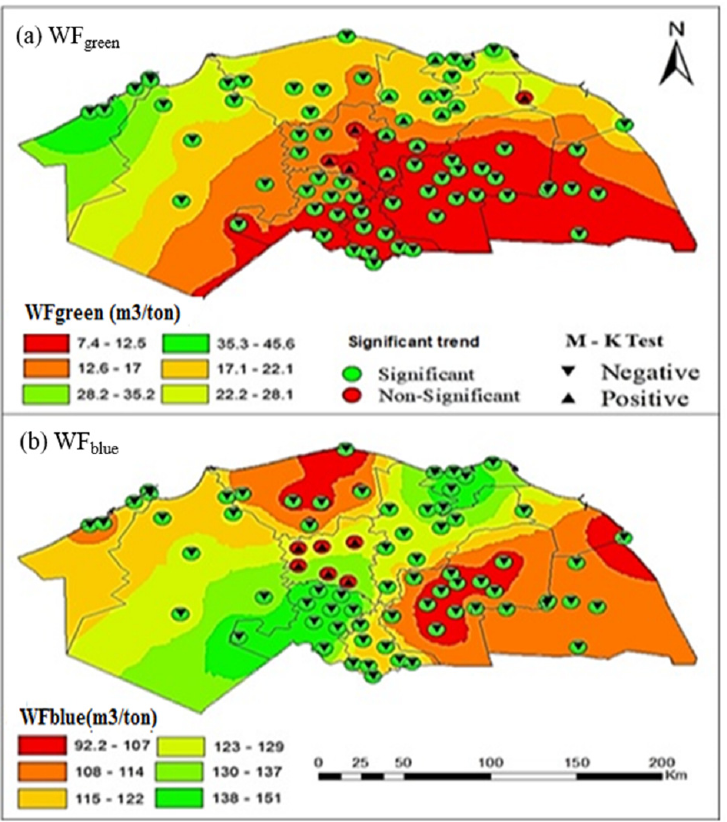
Figure 6. Spatial distribution of the agriculture water footprint from 1990 to 2016: “( a )” WF green , and “( b )” WF blue .